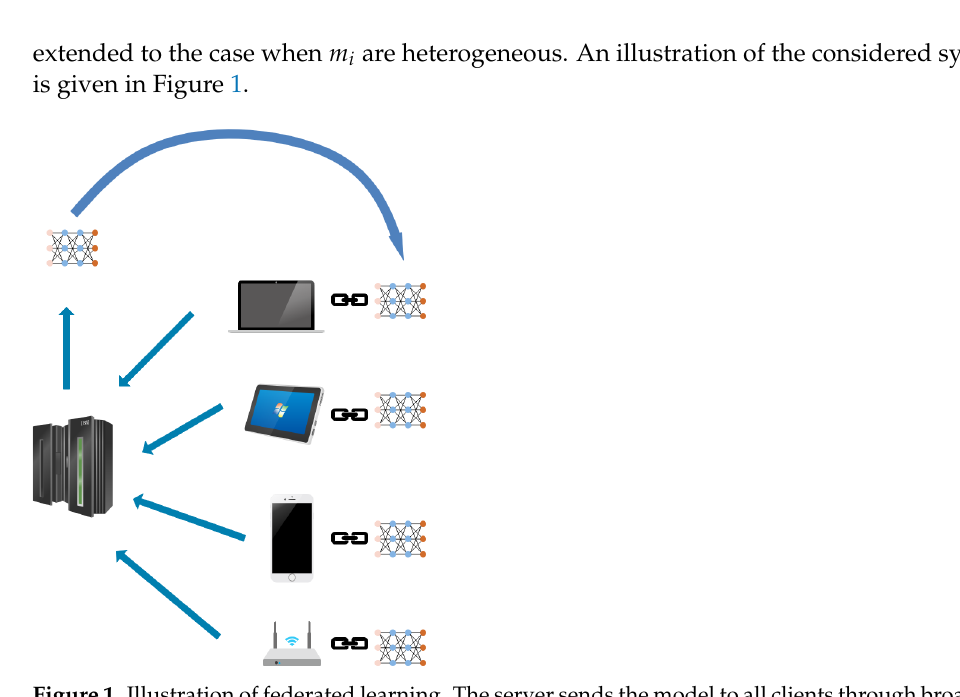
Figure 1. Illustration of federated learning. The server sends the model to all clients through broadcast and the clients submit it to the server for aggregation after local